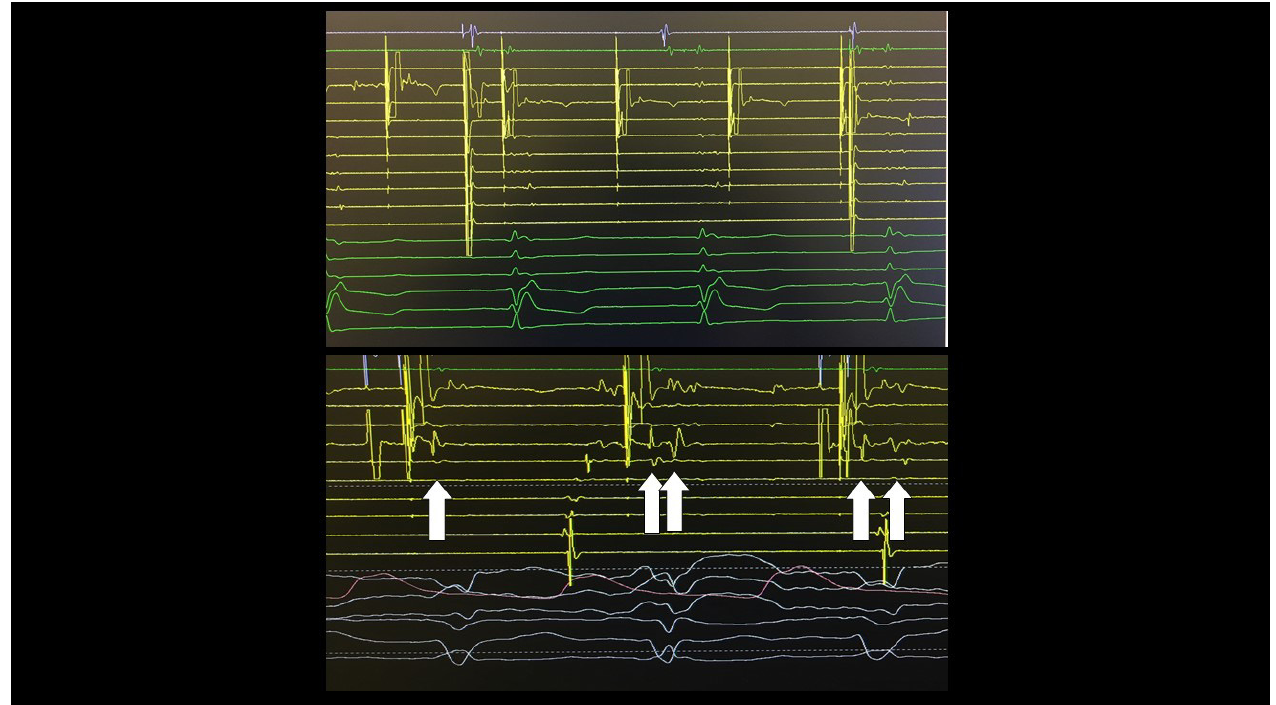
Fig. 4 – Upper panel: pacing along the line after ablation did not capture ventricular myocardium. Lower panel: double ventricular potential increase during pacing from one side of the line during ablation (arrows).